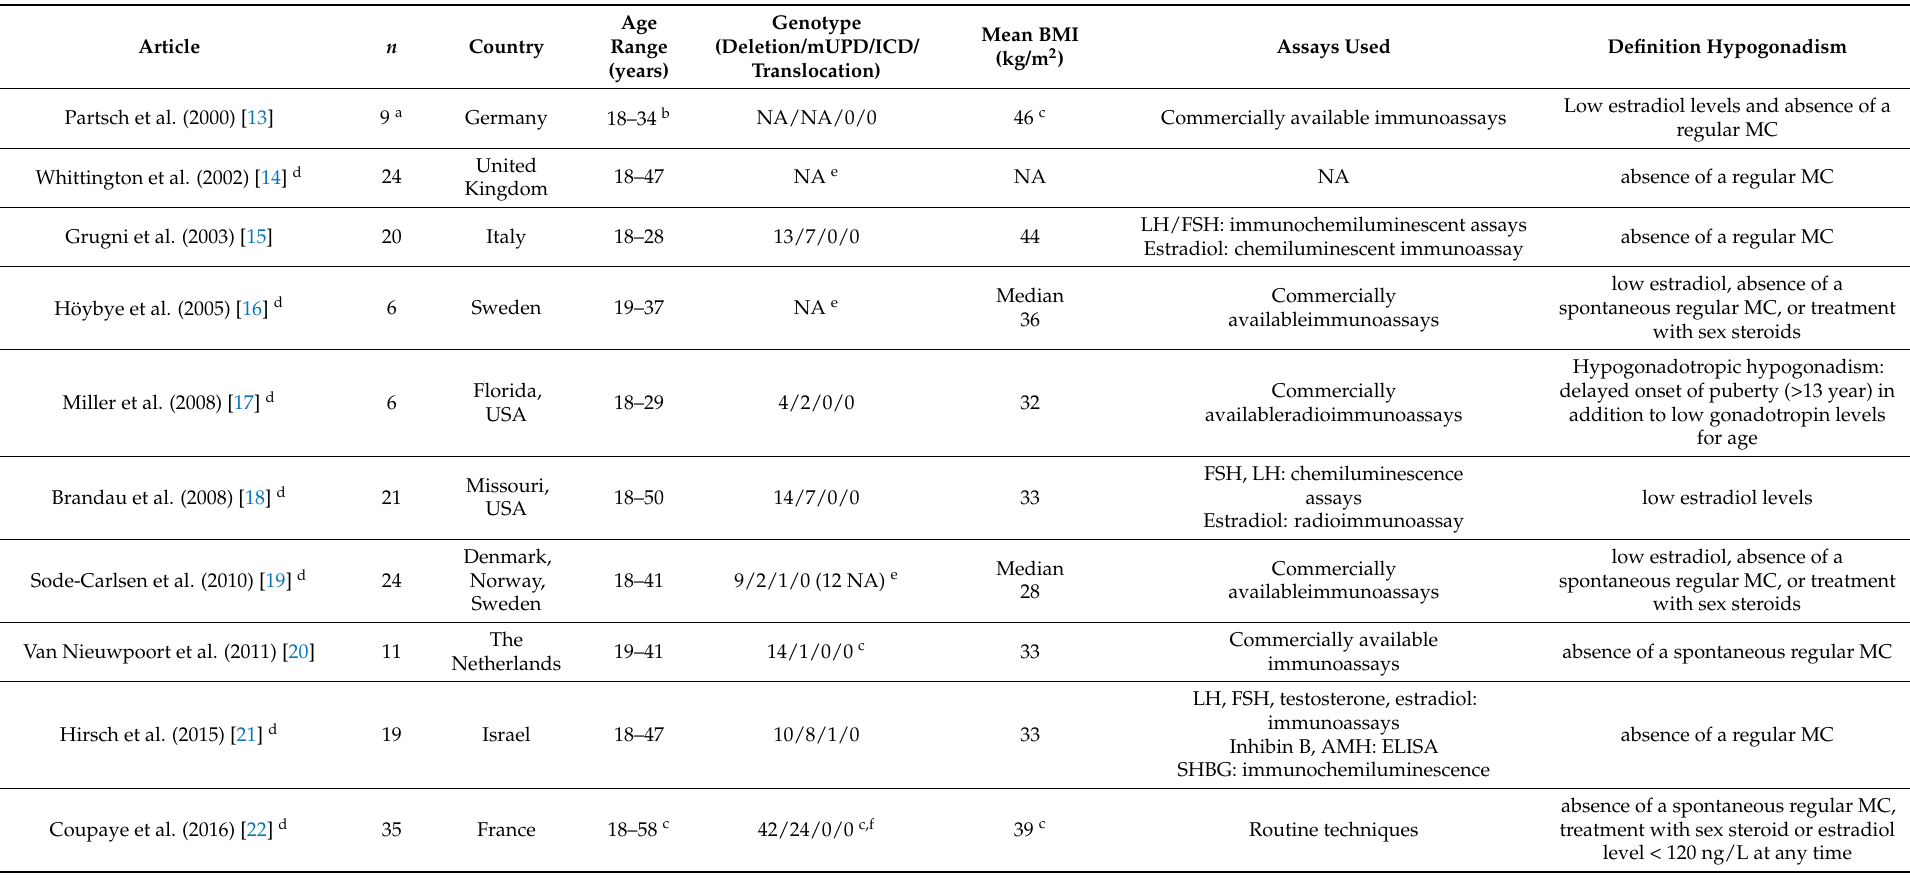
Table 4. Literature review of hypogonadism in women with Prader-Willi syndrome (Part